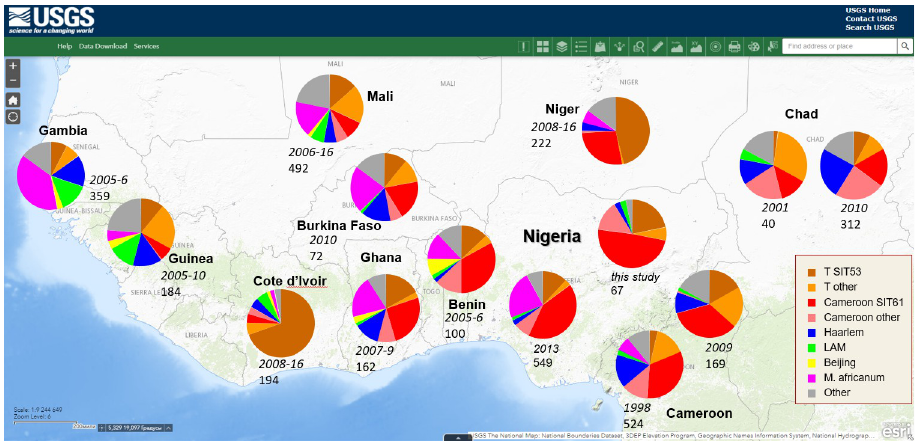
Fig 3. Geographic distribution of the main M . tuberculosis spoligotype lineages in Nigeria and other parts of West Africa (see S10 Table in S1 File for details and references). For each setting we show the years of surveillance and number of isolates studied. Free map: USGS National Map Viewer (public domain): http://viewer.nationalmap.gov/ viewer/.